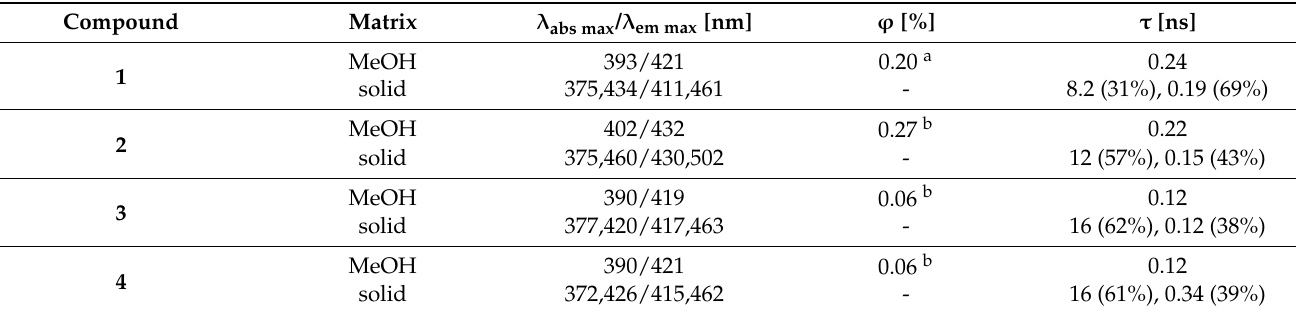
Table 5. Photophysical data of thallium(I)